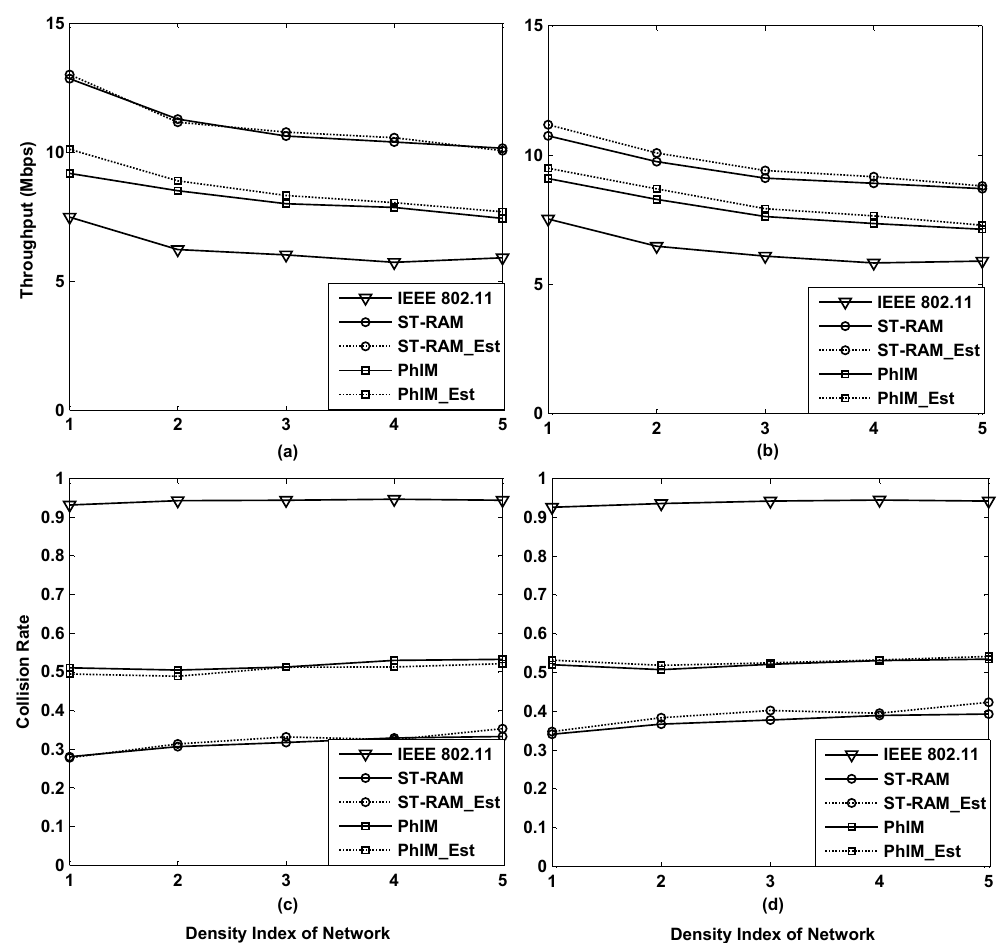
Figure 8. Throughput performance of different data collection methods for lattice deployed networks ( a ) and the random deployed networks ( b ); Collision rate of different data collection methods for lattice deployed networks ( c ) and random deployed networks ( d